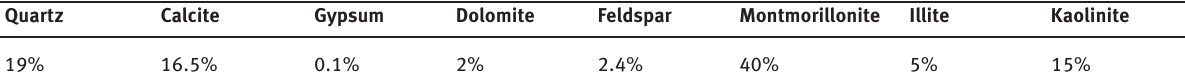
Table 4: Mineralogical composition of the studied soil. Quartz Calcite Gypsum Dolomite